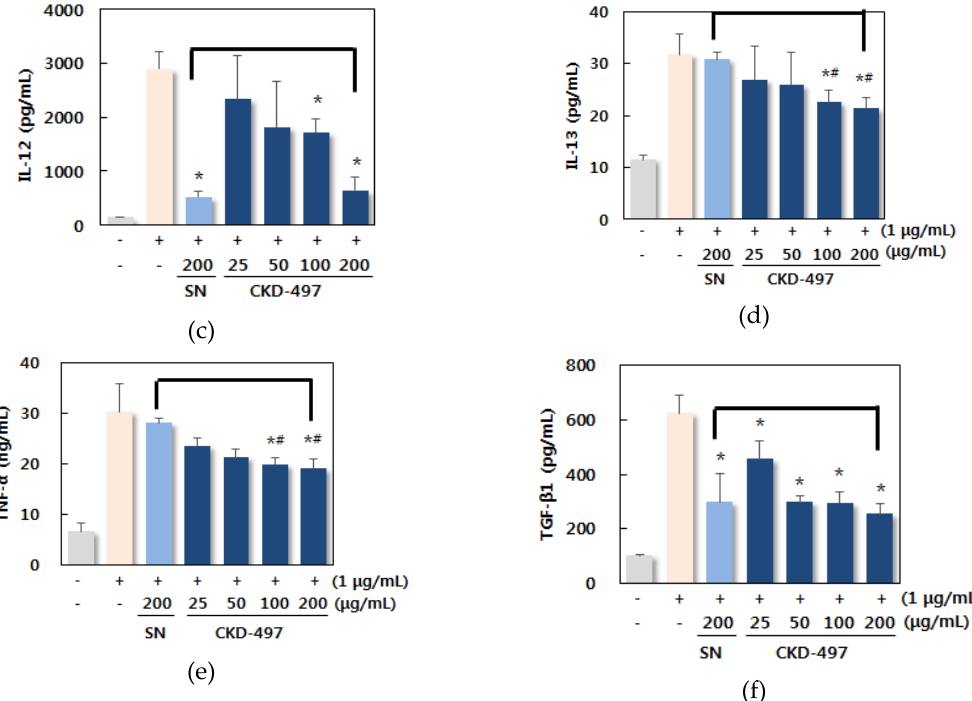
Figure 2. CKD-497 reduced cytokines in Raw 264.7 cells. Supernatant of cells after CKD-497 treatment was harvested. The level of ( a ) Nitric oxide (NO) assay was conducted and ( b ) interleukin 8 (IL-8) ( c ) IL-12 ( d ) IL-13 ( e ) tumor necrosis factor α (TNF-α) and ( f ) transforming growth factor-β1 (TGF-β1) was measured by ELISA in accordance with manufacturer’s instructions. Synatura was used as a positive control. All experiments were repeated three times and data were expressed as the mean ± standard error of the mean (SEM) ( n = 3). * P < 0.05 compared with the induced group [lipopolysaccharide (LPS)-treated group]. # P < 0.05 compared with the Synatura (SN) group.